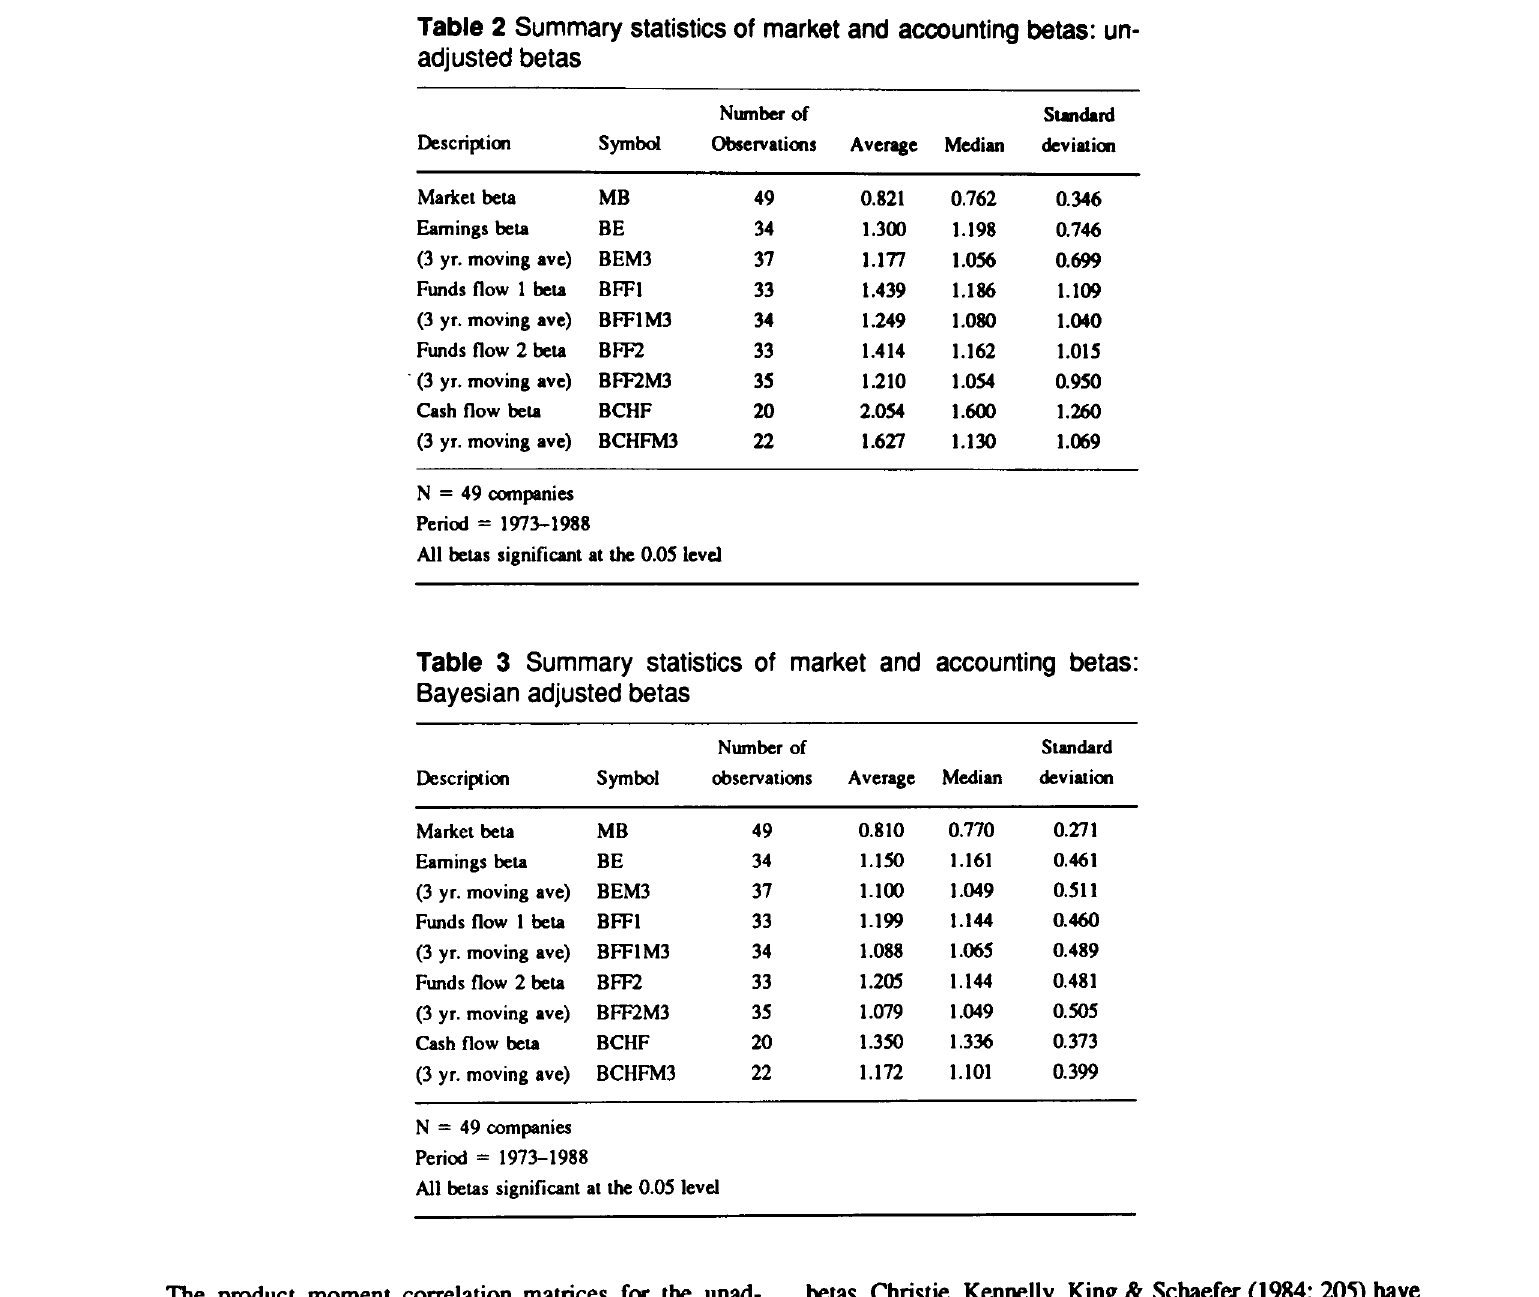
Table 2 Summary statistics of market and accounting betas: un